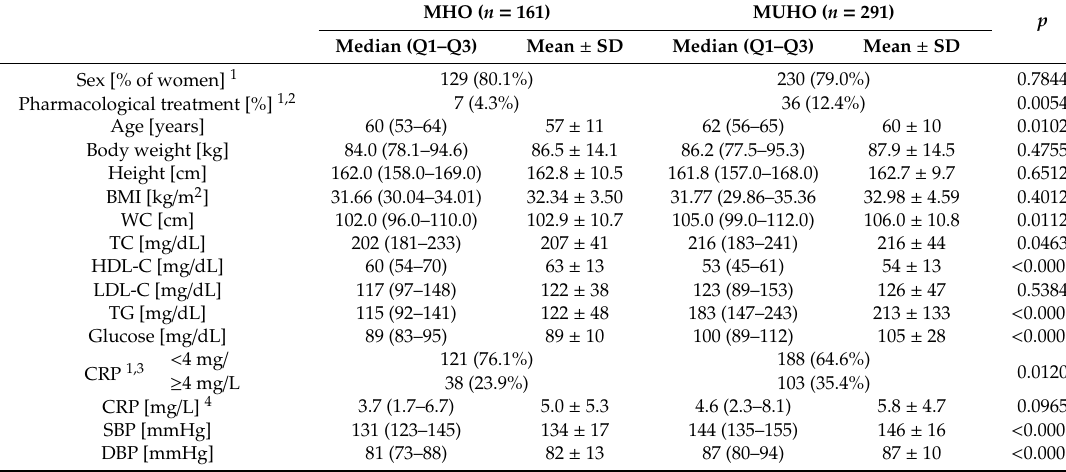
Table 2. Comparison of MHO and MUHO